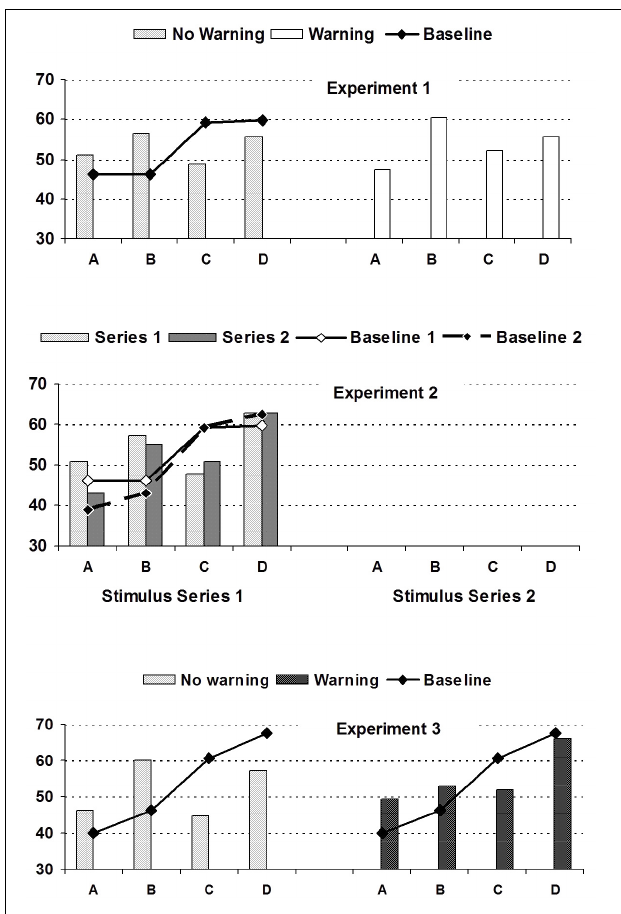
FIGURE 1 | Mean evaluative ratings (averaged across traits) of target persons A, B, C, D by experimental conditions (warning vs. no warning vs. no-repetition baseline) across experiments.